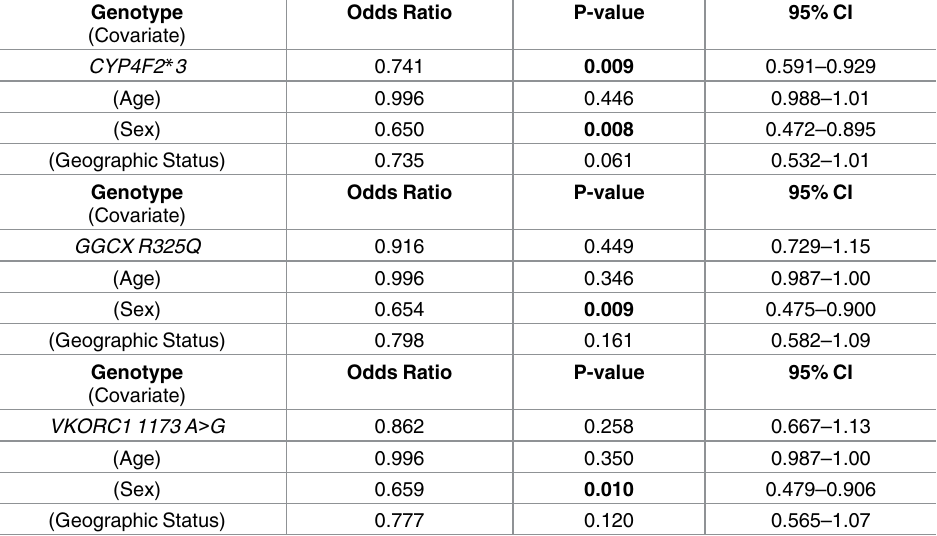
Table 6. Multivariate association analysis of PIVKA-II status and CYP4F2 * 3 , GGCX R325Q , and VKORC1-1173A > G genotypes. Genotype Odds (Covariate)